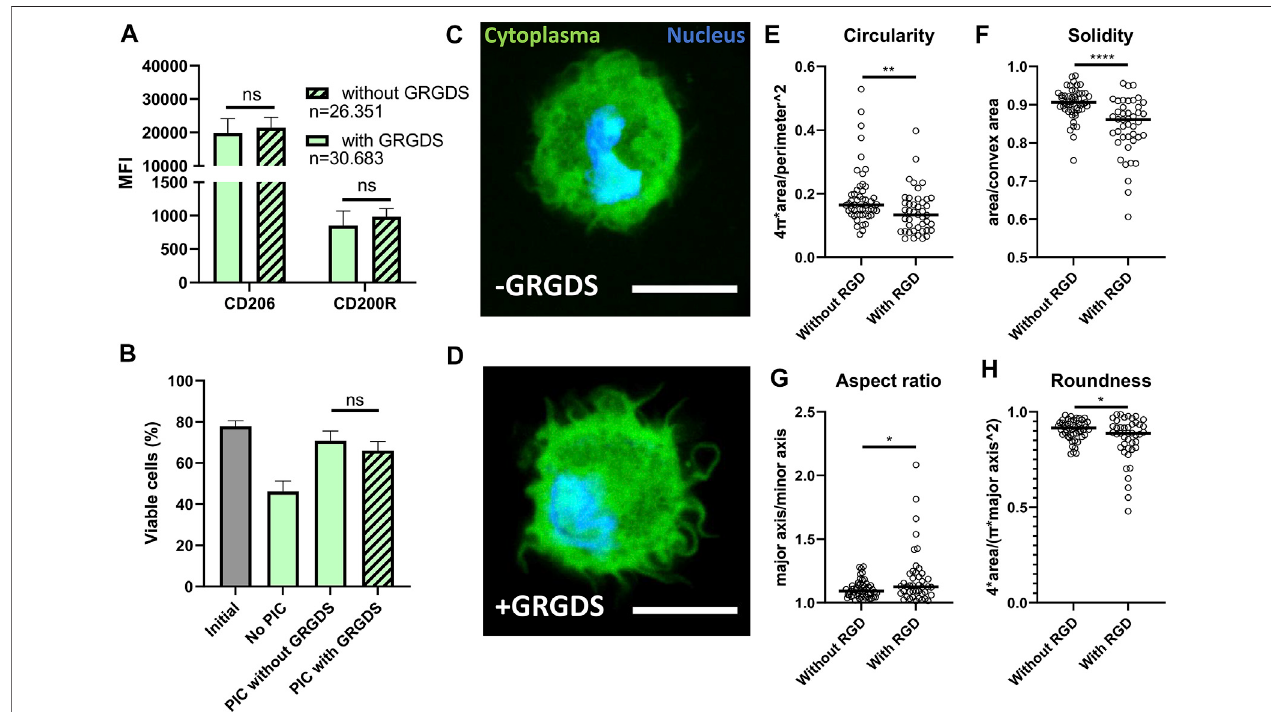
FIGURE 6 | Effects of RGD functionalization of PIC hydrogels on droplet encapsulated Macrophages. (A) MFI representing expression of CD206 and CD200R on macrophages cultured in hydrogel droplets with and without GRGDS fragments for 2 days. Individual data points represent MFI of fi ve different donors. “ n ” indicates number of cells measured from all donors combined. (B) Percentage of viable cells after 2-day culture in droplets without PIC hydrogel, with PIC and with PIC functionalized with GRGDS molecules compared to the initial viability before encapsulation. Data represents mean of fi ve independent donors. (C,D) confocal imagesofmacrophages(cytoplasma (cid:2) green,nucleus (cid:2) blue),inhydrogeldropletsbothwithandwithoutGRGDSmoleculesincorporated.Imageswerecapturedat × 63 magni fi cation,scalebarerepresents10 μ m. (E – H) Circularity,Solidity,AspectratioandRoundness,respectively,ascalculatedfromarea,convexarea,perimeter,major andminoraxisderivedfrom93confocalimagesfromtwodifferentdonors(withoutRGD; n (cid:2) 50,WithRGD; n (cid:2) 43)wheretheblacklineindicatesmedian.With* p < 0.05 ** p < 0.005 and **** p <